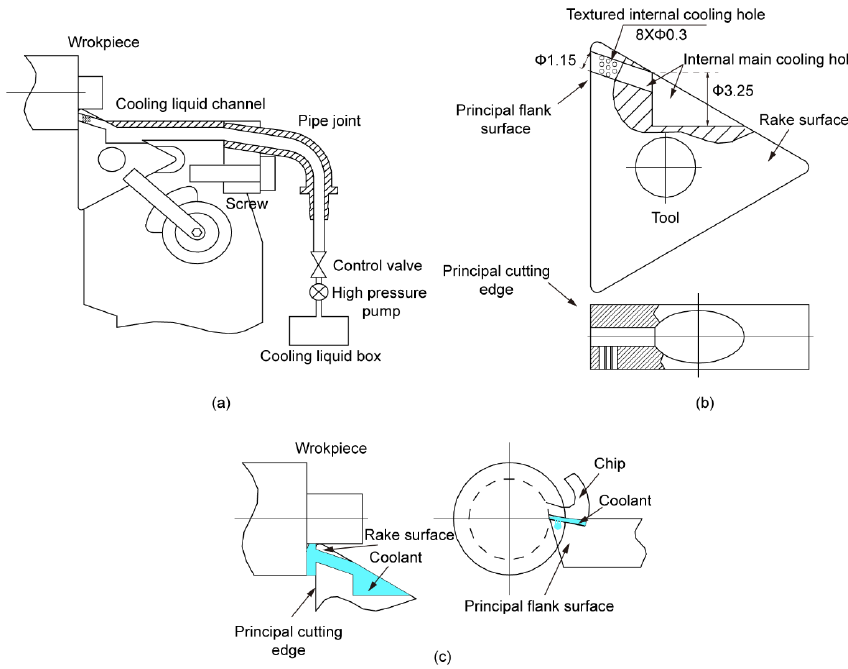
Figure 1. The experimental setup of the cutting system with internal cooling.